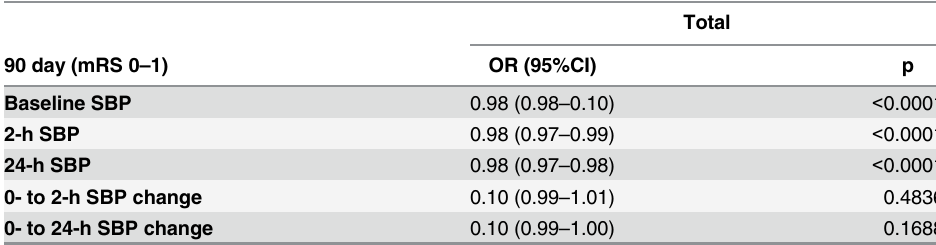
Table 2. BP and favorable outcome (mRS 0 – 1 at 90